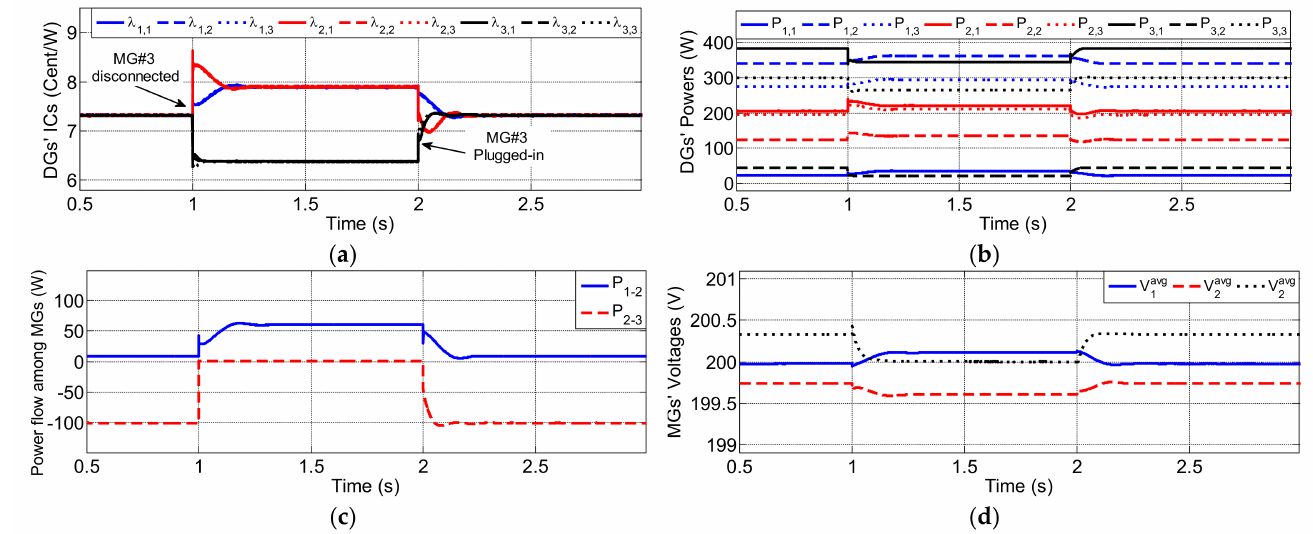
Figure 7. Plug-and-play feature: ( a ) DGs’ incremental costs, ( b ) DGs’ generations, ( c ) Exchanged power between MGs, and ( d ) Average voltages across